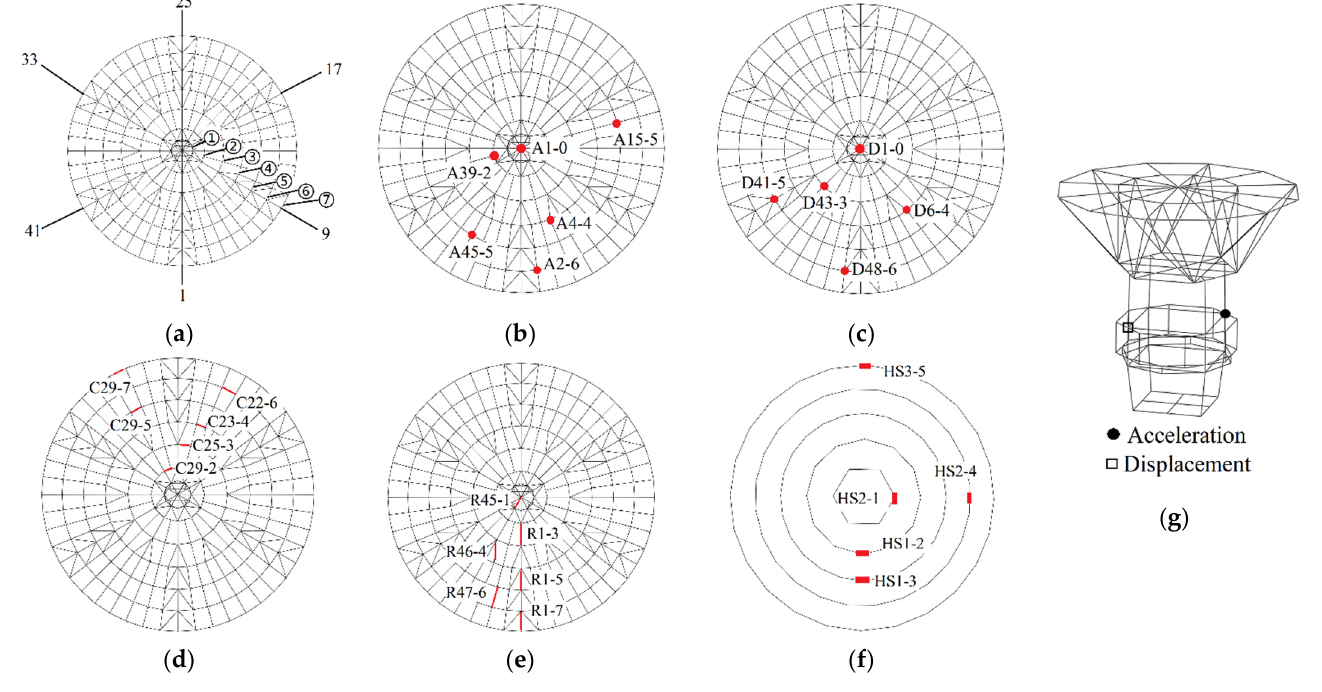
Figure 8. Measuring point layout: ( a ) Radial number and ring number; ( b ) Measuring point of acceleration; ( c ) Measuring point of displacement; ( d ) Measuring point of ring bar; ( e ) Measuring point of radial bar; ( f ) Measuring point of hoop cable; ( g ) Measuring point of center-hung scoreboard.